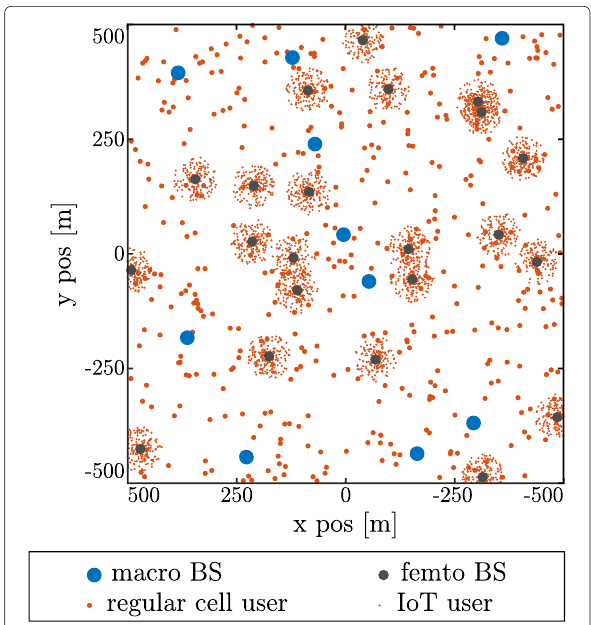
Fig. 11 Simulation of a large IoT scenario. Network geometry with PPP distributed macro ( d = 10 km − 2 ) and femto ( d = 25 km − 2 ) BSs, regular cell users ( d = 400 km − 2 ) and IoT users ( d = 25000 km − 2 ) distributed in circular clusters of radius r = 50 m around the femto